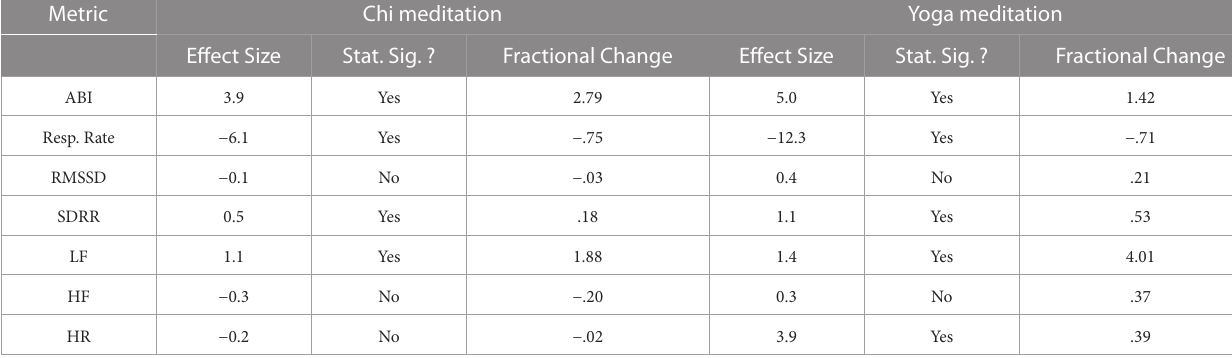
TABLE3 Comparisonoftherestandmeditationcohorts.Whentheeffectsizeandfractionalchangearepositive,themetricmeasuredforthemeditationcohortis larger.Anegativeeffectsizeandfractionalchangeimplythatthemetricmeasuredfortherestcohortislarger.